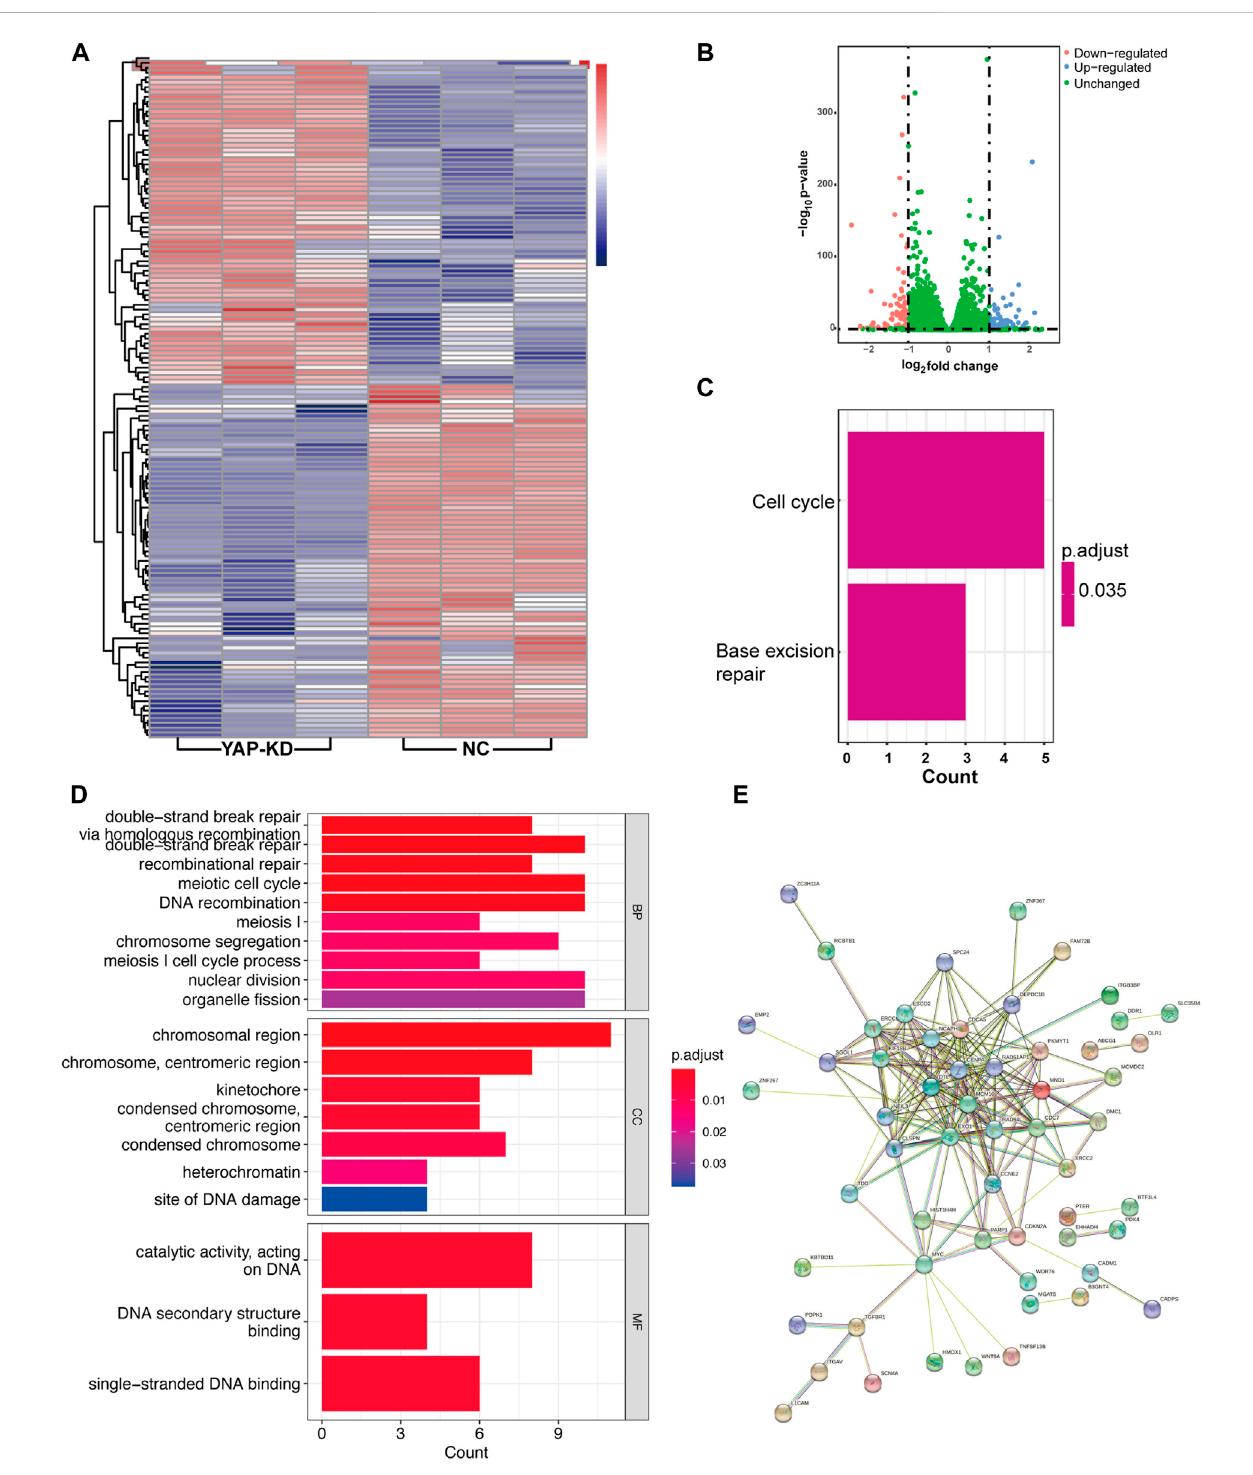
FIGURE 1 RNA-seq analysis oftotalDEGsforYAP-KD hBdSMC. (A) .TheheatmapofYAP-KD andNChBdSMCs. (B) .Thevolcano plotofDEGs. (C) .KEGGanalysis of DEGs. (D) . GO analysis of DEGs. (E) . The PPI network of DEGs. hBdSMC: human bladder smooth muscle cell; KD: knock-down, NC: nature control, DEG: differentially expressed genes, PPI: protein-protein